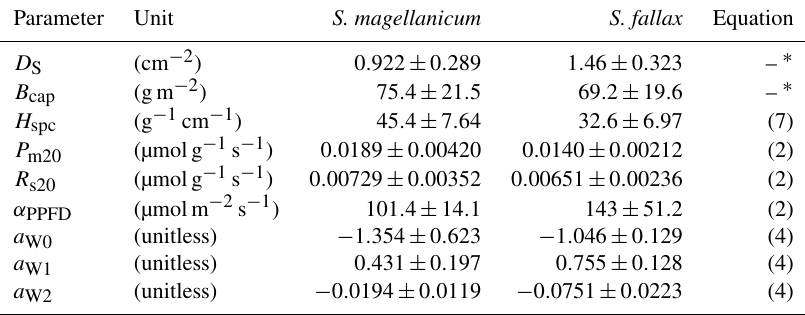
values measured here are well within the range of those reported in the literature for these species (McCarter and Price, 2014; Laing et al., 2014; Bengtsson et al., 2016; Korrensalo et al.,